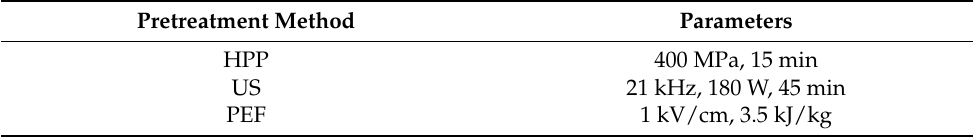
Table 1. Basic parameters of pretreatment methods. applied prior to convective drying.